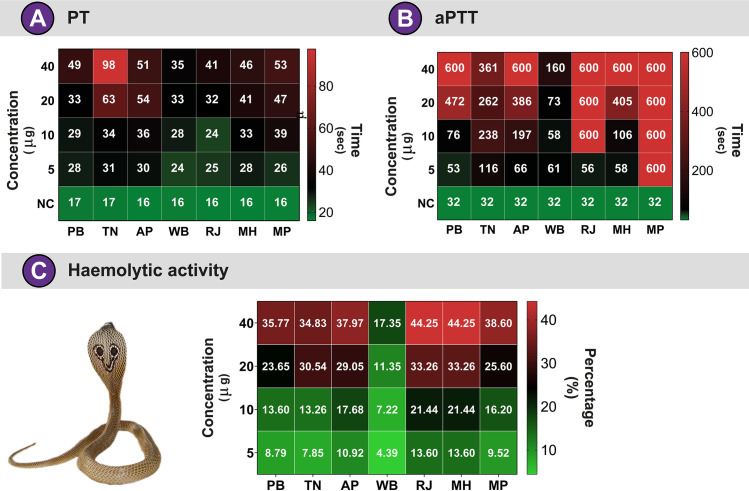
Pan-Indian N. naja venom-induced coagulopathies.The abilities of venoms of various populations of N. naja to cause perturbations to the blood coagulation cascade via extrinsic (A) and intrinsic (B) pathways are depicted here as heatmaps. Numbers inside cells indicate the time (sec) required for the formation of the first fibrin clot. A colour key representing time in sec is also provided for each heatmap. Haemolytic activities of N. naja
(C) venoms, defined as the percentage relative activity of the positive control (0.5% Triton X), are also shown.